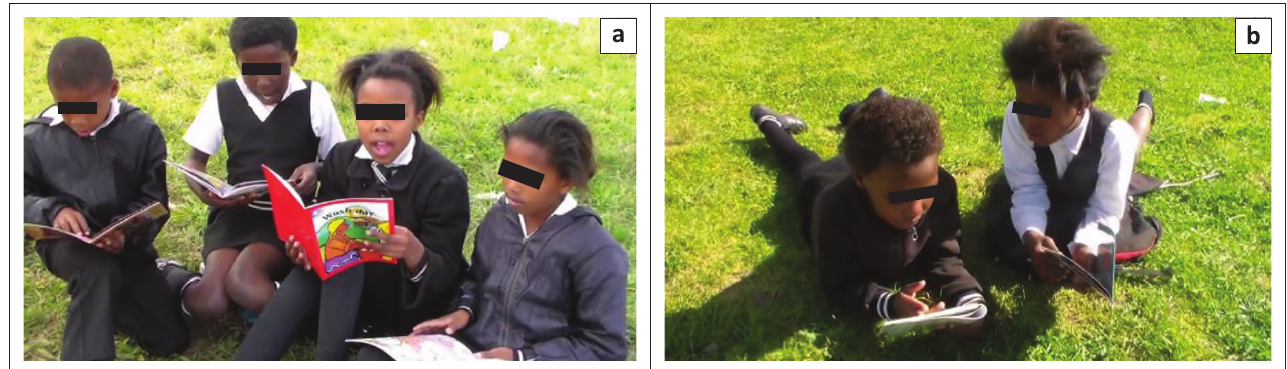
FIGURE 1: Learners reading outside of their classroom (a and b).